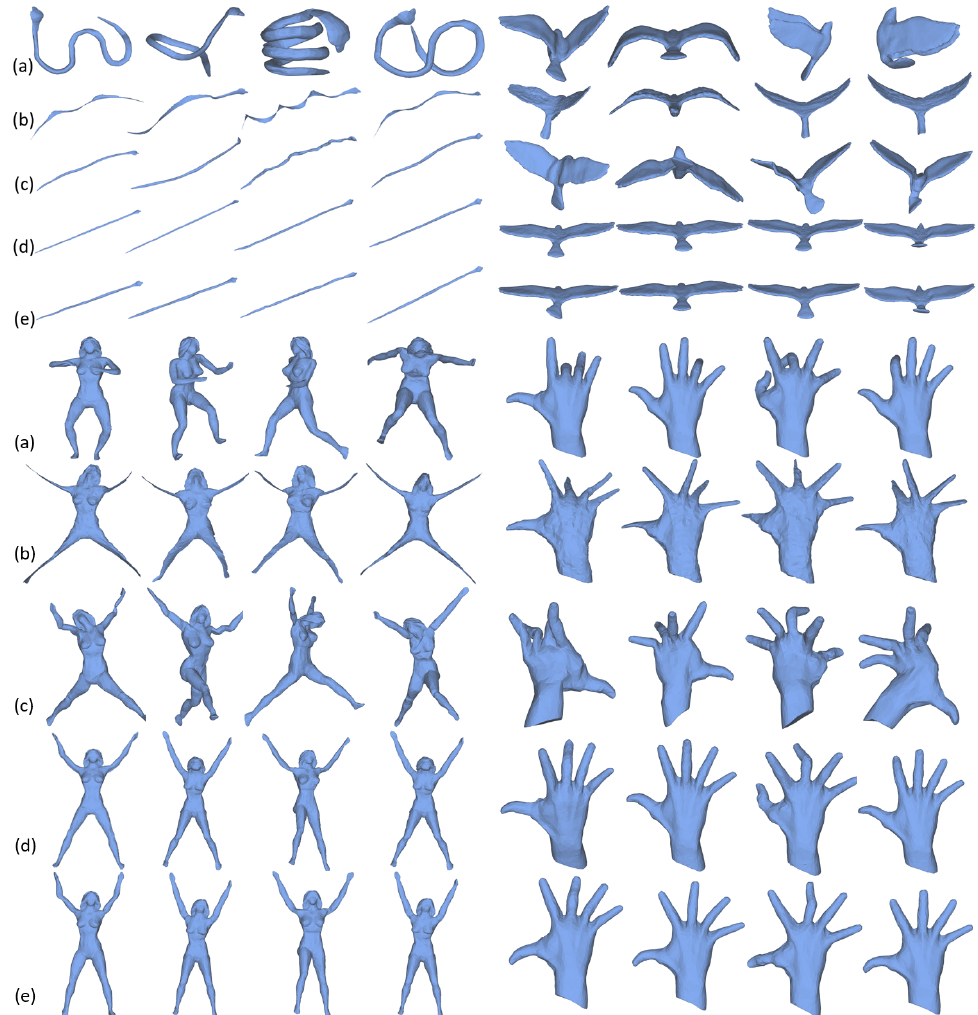
Figure 5. Illustration of mesh unfolding results of different methods. ( a ) original meshes, ( b ) the results of least squares multidimensional scaling method (LSMDS) [11], ( c ) the results of skeleton based canonical form (SCF) [28], ( d ) the results of detail-preserving mesh unfolding (DPMU) [24] and ( e ) our results.